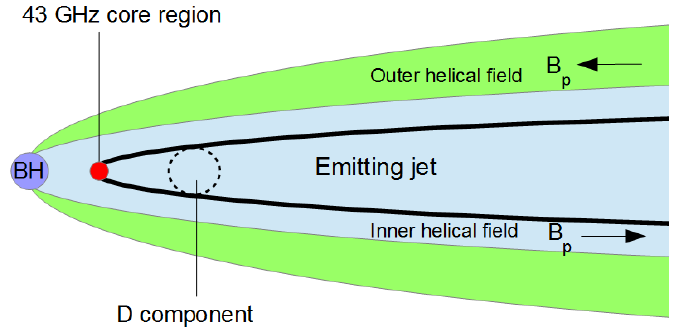
Figure 2. In this jet cartoon, the blue and green colors represent the inner (RM > 0 and B p in the observer’s direction) and outer (RM < 0 and B p in the opposite observer’s direction), respectively. The solid black line and the violet circle mark the emitting jet and the black hole (BH) regions,